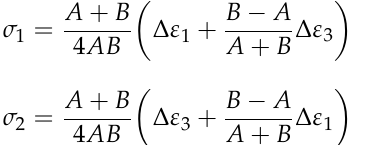
Figure 3. Schematic cross-sections around a hole drilled into tensile RS [19] ( a ) before and ( b ) after hole drilling ( c ) strain gage arrangement direction.